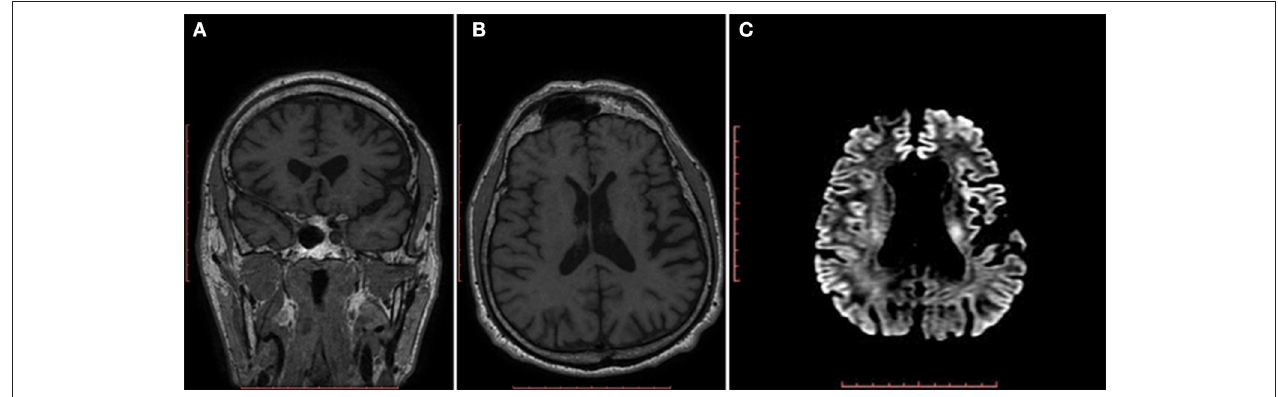
FIGURE 1 | Coronal T1-weighted (A) , axial T1-weighted (B) , and axial diffusion-weighted (C) brain imaging at initial assessment showing left perisylvian atrophy.